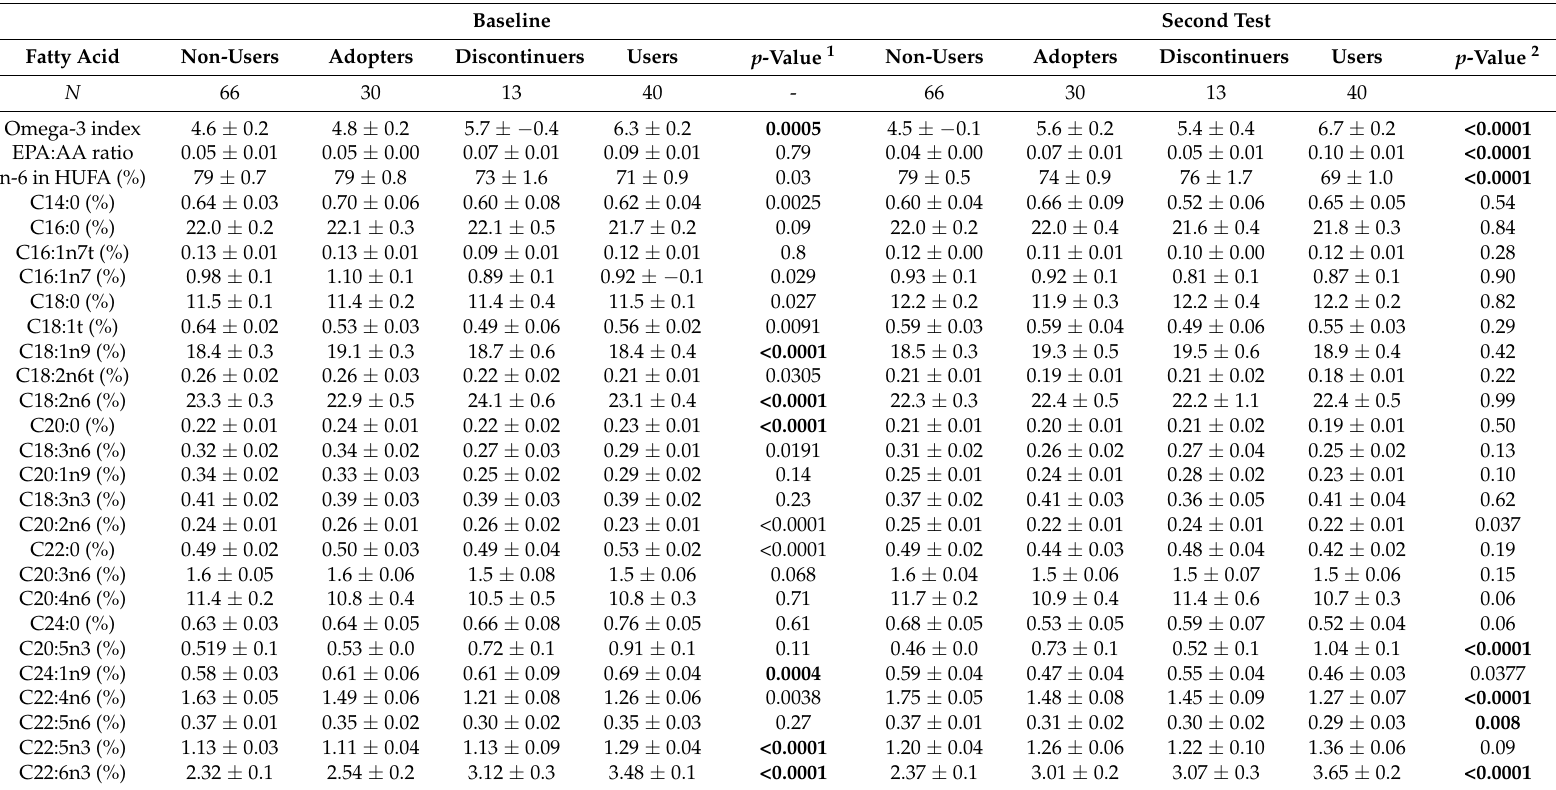
Table 6. Fatty acid values at baseline and second test according to dietary supplementation practices in 149 volunteers who were